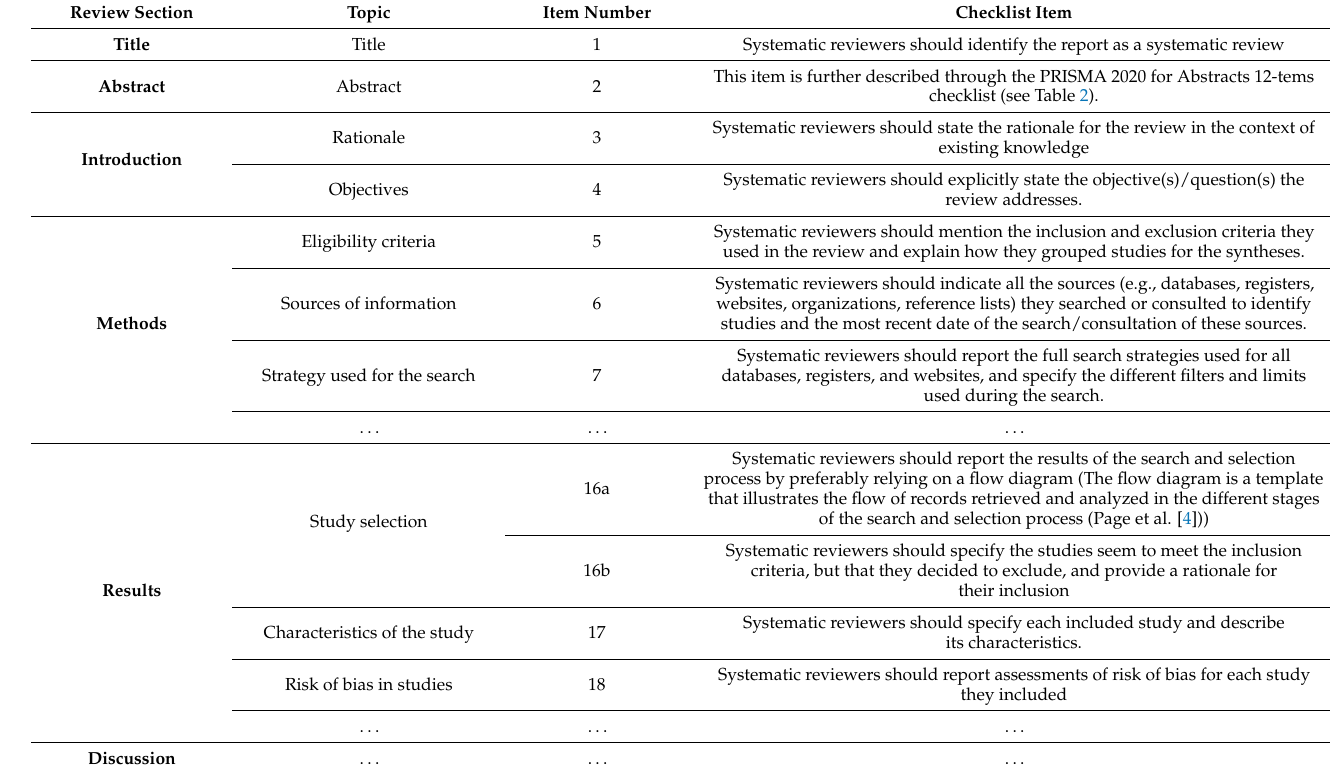
Table A2. An excerpt of the PRISMA 2020 27-item checklist adapted from